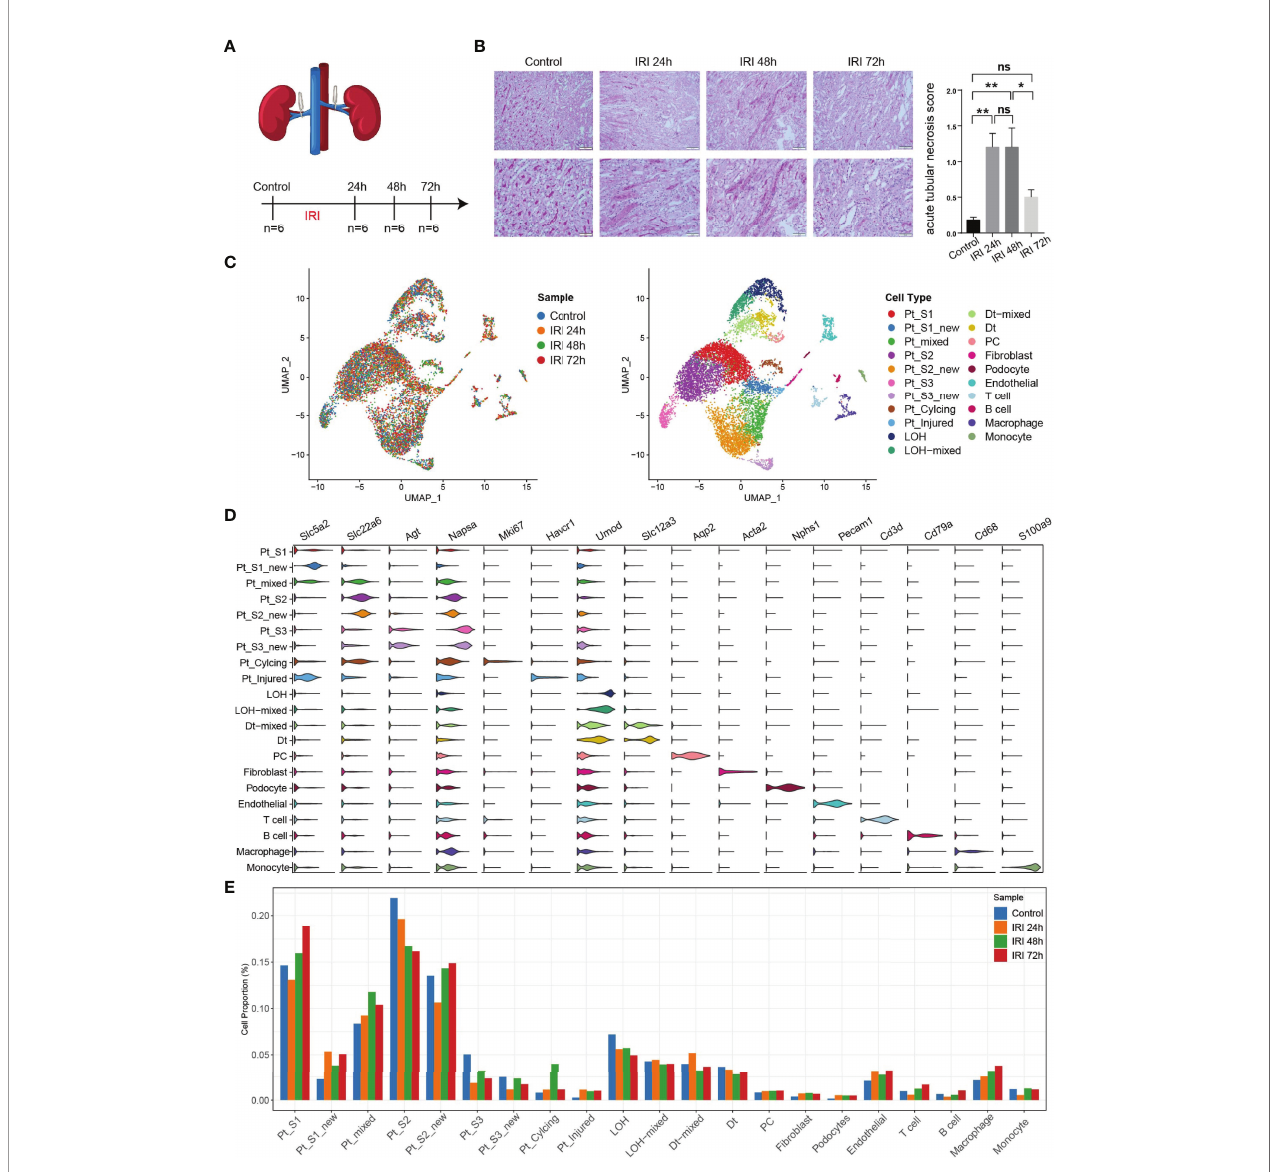
FIGURE 1 | An overview of single cell transcriptomic atlas of mouse IRI kidney. (A) Summary of experimental strategy. n = 6 mice per group. (B) The histopathology images and acute tubular necrosis score in control, IRI 24h, IRI 48h and 72h, One-way ANOVA followed by Turkey ’ s multiple comparisons was used for three or more groups comparisons. * p <0.05, ** p <0.01. (C) The distribution of 52,162 high-quality kidney cells in distinct sample timepoints (left) and cell types (right). (D) Cell type annotation and representative marker genes expression in 21 cell types. (E) Relative contribution of each cell type in distinct sample timepoints. ns, Not Statistically Signi fi